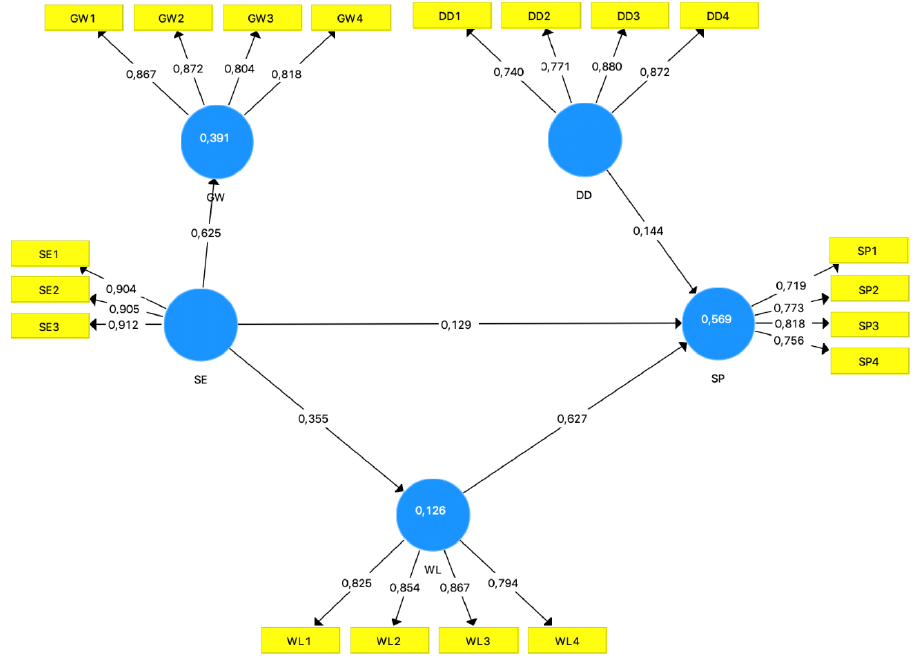
Figure 1. Result of Hypotheses